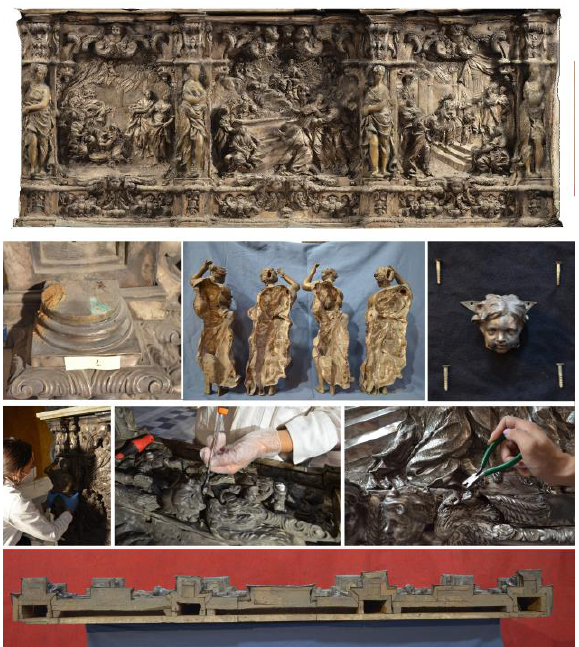
Figure 5 . On the top: pre - restoration photogrammetric textured mesh of the frontal; on the bottom: disassembly of frontal